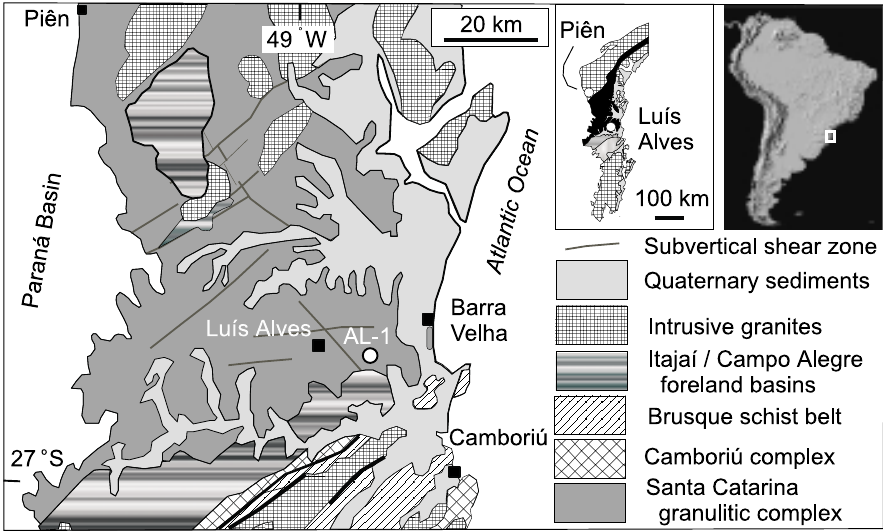
Fig. 1 – Geological map of the Santa Catarina granulitic complex, showing location of dated sample, AL-1. South of the map area, the geology is dominated by the Paleoproterozoic Camboriú granitic- gneissic complex and by the Neoproterozoic Florianópolis K-granitic batholith. Insets show location of study area in South America and regional